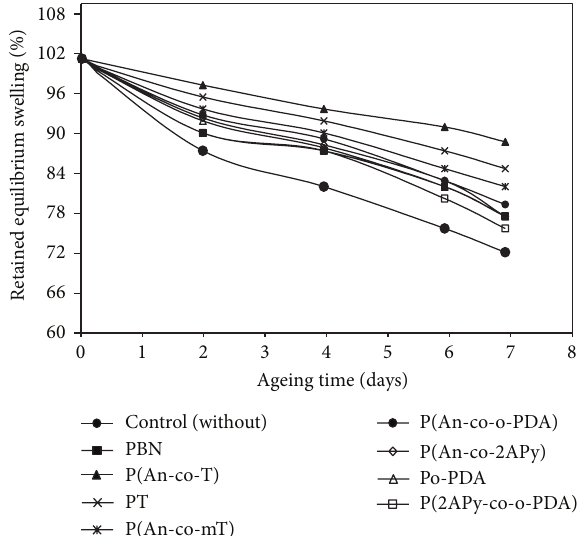
Figure 3: Retained equilibrium swelling versus ageing time for NR vulcanizates.